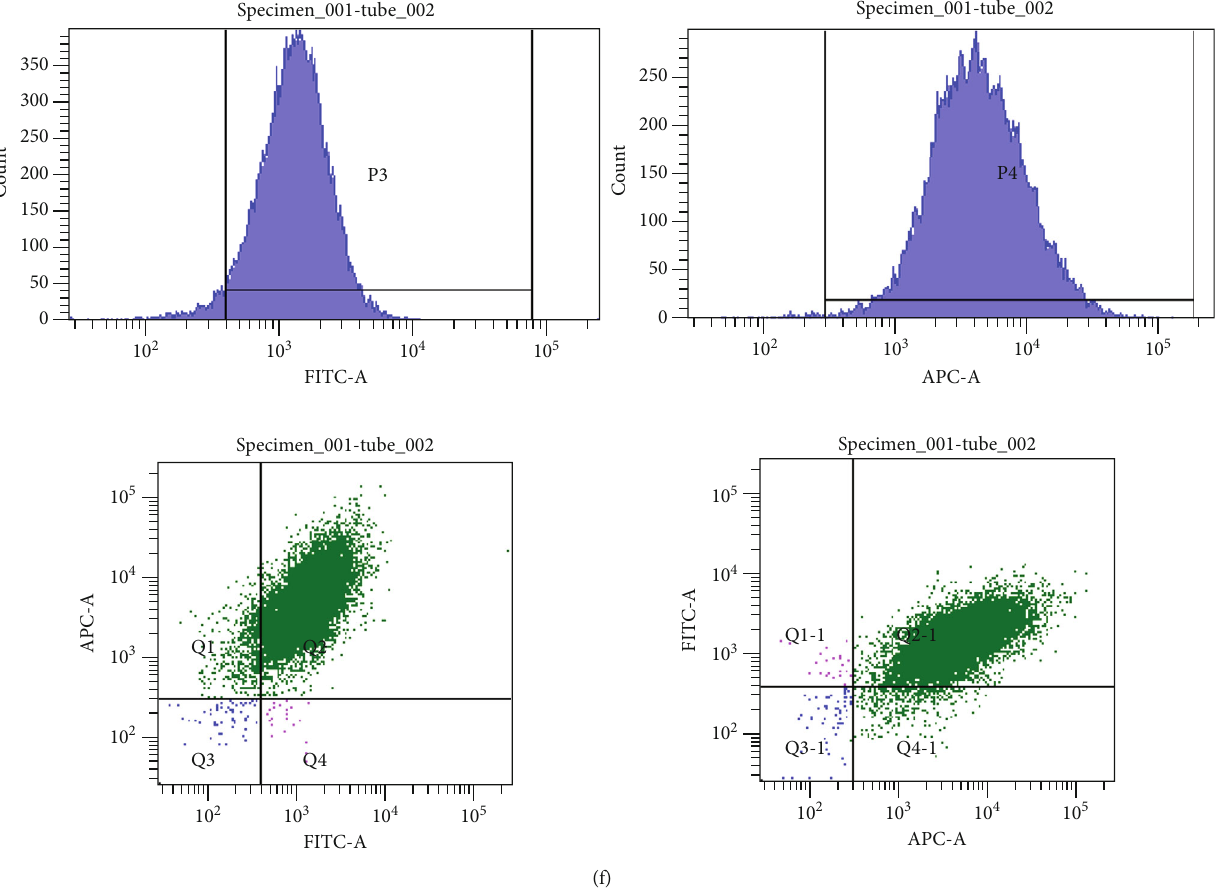
Figure 4: Expression of dual-porcine OCT4 reporter system and pluripotency markers in porcine embryonic stem cells.Reporter fl uorescent genes and pluripotency markers were checked in the protein expression level. (a) Porcine embryonic stem cells with the OCT4 reporter system. (b) Porcine embryonic stem cells without the OCT4 reporter system. (c) Porcine embryonic fi broblasts with the OCT4 reporter system. (d) Embryonic bodies after di ff erentiation from porcine embryonic stem cells with the OCT4 reporter system. (e) Porcine embryonic stem cells without the reporter system. (f) Porcine embryonic stem cells with the reporter system. Flow cytometry showed that porcine embryonic stem cells with the OCT4 reporter system have 99.6% positive rates of fl uorescence compared to those of the control